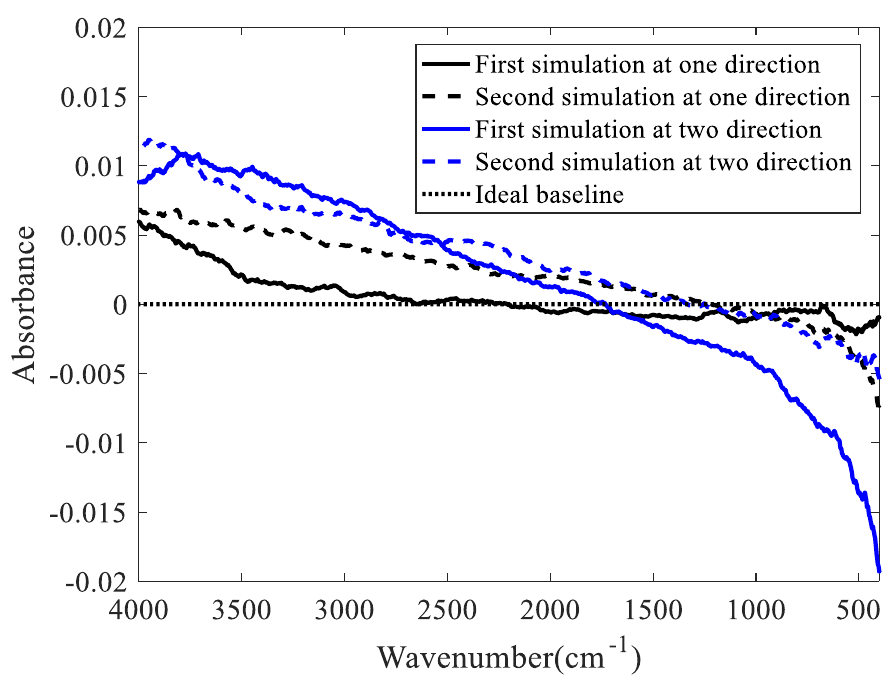
Figure 5. Moving mirror at a random tilt angle.